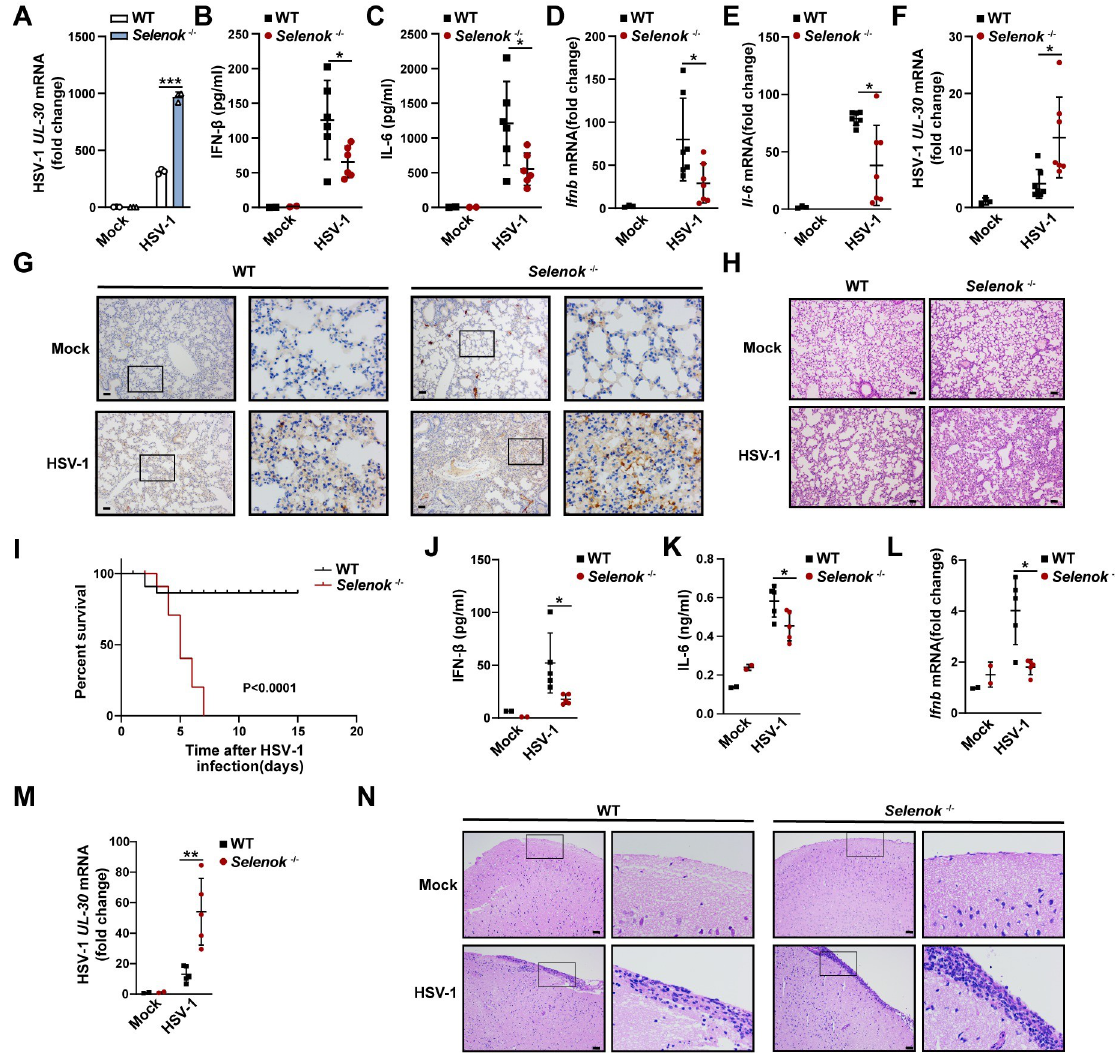
Fig 3. Selenok deficiency inhibits innate immune responses against HSV-1 in vivo . (A) Real-time PCR analysis of HSV-1 UL30 mRNA levels in PMs stimulated with HSV-1. (B-F) Mice were infected with HSV-1 for 8h by i.p. injection. (B and C) Serum levels of IFN- β and IL- 6 analyzed by ELISA (mock, n = 2; HSV-1, n = 6). (D and E) Real-time PCR analysis of Ifnb and Il-6 mRNA levels in spleen homogenate (mock, n = 3; HSV-1, n = 7). (F) HSV-1 viral burden determined by real-time PCR analysis of HSV-1 UL30 mRNA levels in spleen homogenates (mock, n = 3; HSV-1, n = 7). (G and H) Mice were infected with HSV-1 for 36h by i.p. injection. (G) HSV-1 viral burden was determined by ICP-5 immunohistochemical staining of lung slices. Scale bar, 50 μ m. (H) Hematoxylin and eosin staining of the lung slices. Scale bar, 50 μ m. (I) Kaplan–Meier method was used to evaluate survival curves (n = 15 per condition). (J-L and N) Mice were infected with HSV-1 for 12h by intracerebral injection. (J and K) Serum levels of IFN- β and IL-6 were analyzed by ELISA (mock, n = 2; HSV-1, n = 5). (L) Real-time PCR analysis of Ifnb mRNA levels in brain homogenate (mock, n = 2; HSV-1, n = 5). (M) Mice were infected with HSV-1 for 40h by intracerebral injection. HSV-1 viral burden determined by real-time PCR analysis of HSV-1 UL30 mRNA levels in brain homogenates (mock, n = 2; HSV-1, n = 5). (N) Hematoxylin and eosin staining of the brain slices. Scale bar, 50 μ m. Statistical significance was determined by unpaired two-sided multiple Student’s t-tests in A-F and J-M. Data represent mean ± standard deviation (SD) or one representative image from three independent experiments. Graph I was determined by the log-rank Mantel-Cox test. * : P < 0.05, ** : P < 0.05, *** P: < 0.001. knockdown PMs (S4A and S4B Fig). The activation of IRF3, TBK1, STAT1, and Viperin stim- ulated by cGAMP or DMXAA was also attenuated in Selenok -knockdown PMs (S4C and S4D Fig). In an animal model of STING activation, compared to WT mice, the secretion of IFN- β